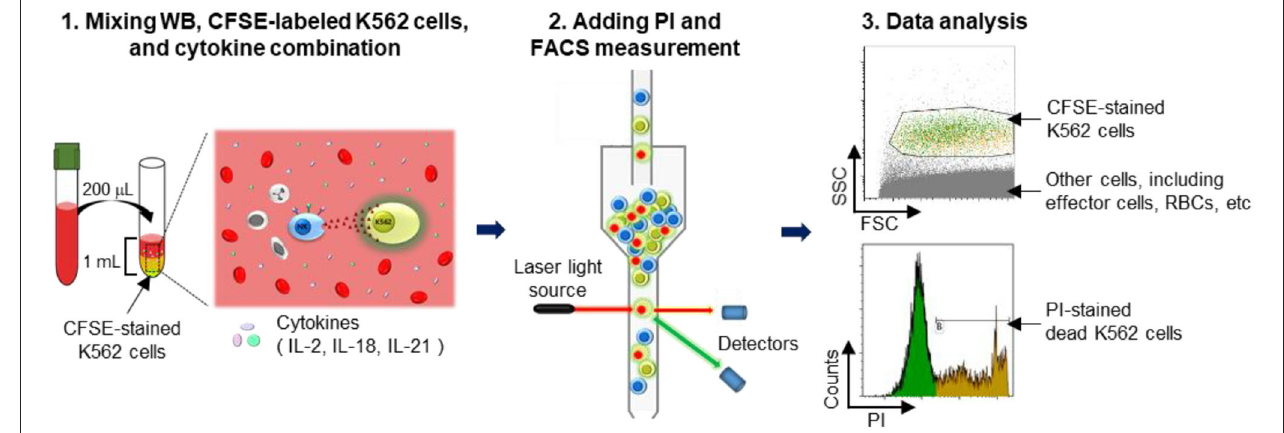
FIGURE 1 | Schematic illustration of the experimental procedure. A detailed explanation is provided. Briefly, whole blood (WB) was mixed overnight with carboxyfluorescein succinimidyl ester (CFSE)-labeled K562 cells in media containing cytokines. Thereafter, propidium iodide (PI) was added to detect dead cells, and the killed target cell ratio was determined using flow